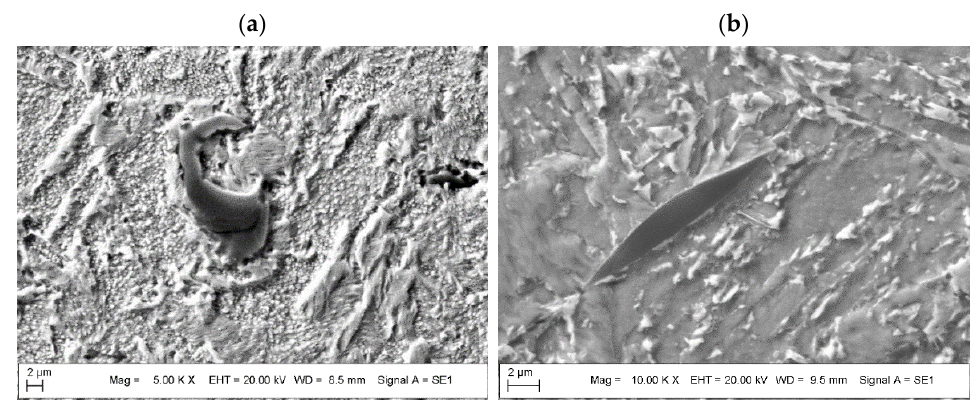
Figure 9. Images of the microstructure of the AM M789 maraging steel with combined oxide inclusions of Ti and Al (TiO 2 :Al 2 O 3 ) under: ( a ) solution annealed conditions and ( b ) solution annealed and aged 9 h.